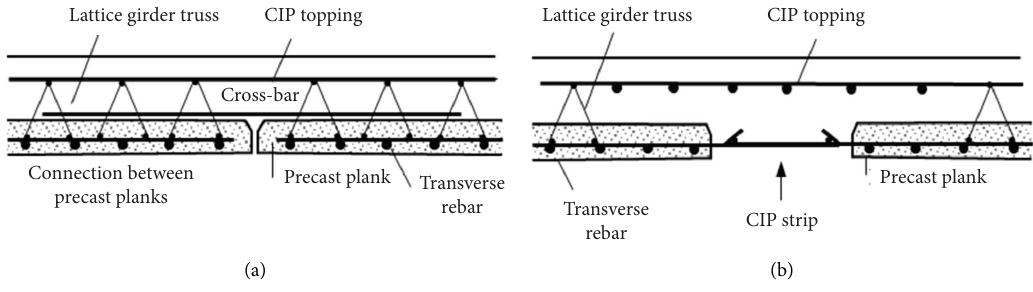
Figure 2: Two types of connections for LGS. (a) Closely attached precast planks [5]. (b) CIP concrete strip